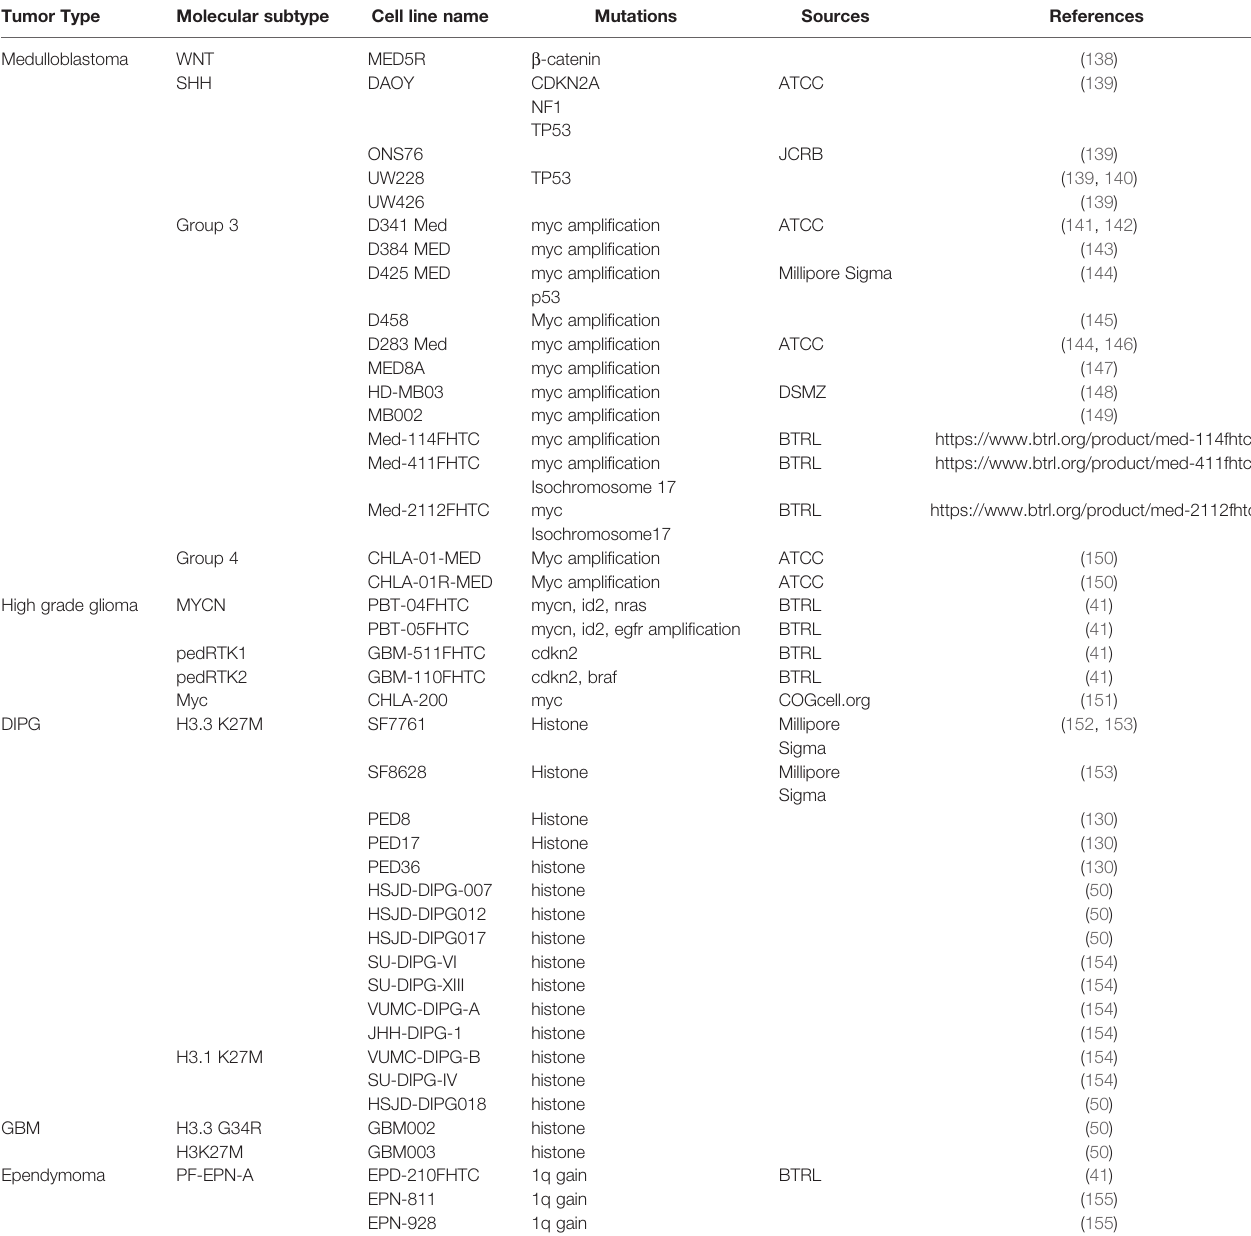
TABLE 2 | Established pediatric brain tumor cell lines with de fi ned molecular